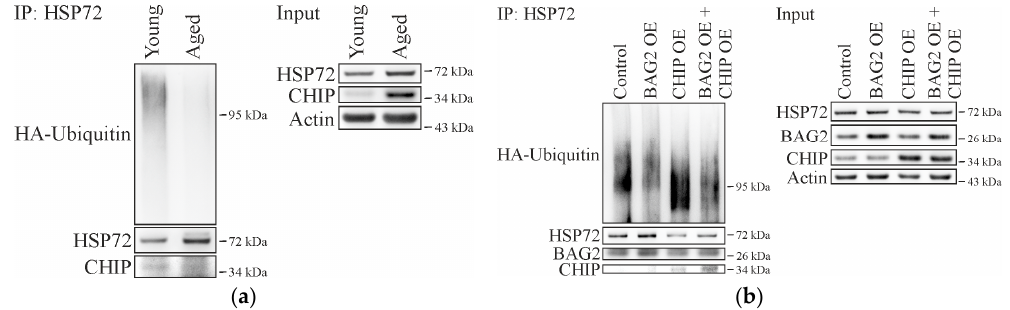
Figure 4. ( a ) Co-IP analysis of young and aged fibroblasts that were transfected with HA-tagged ubiquitin and Flag-tagged HSP72. The accumulation of poly-ubiquitinated proteins was induced by MG132 treatment (4 µM, 4 h) prior to cell lysis. The levels of HSP72 ubiquitination were visualized by immunoblot analysis (left panel). The input fraction is shown on the right panel; ( b ) Aged fibroblasts were transiently transfected with HA-tagged ubiquitin and FLAG-tagged HSP72 and either EGFP (control), BAG2, CHIP or with BAG2 and CHIP. The accumulation of poly-ubiquitinated proteins was induced by treatment with MG132 (4 µM, 4 h) prior to cell lysis. HSP72 was immunoprecipitated and levels of ubiquitination proteins were verified by immunoblot analysis (left panel). Purified mouse IgG was used as control (not shown). The right panel shows relative protein levels in cell lysates used for Co-IP (Input).